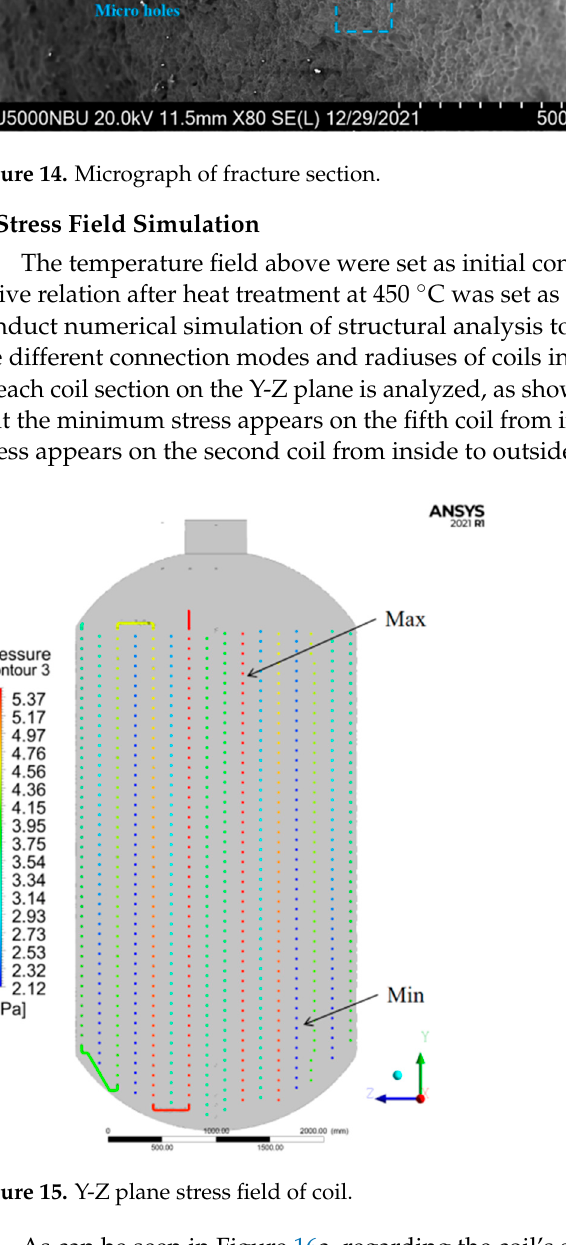
Figure 14. Micrograph of fracture section.